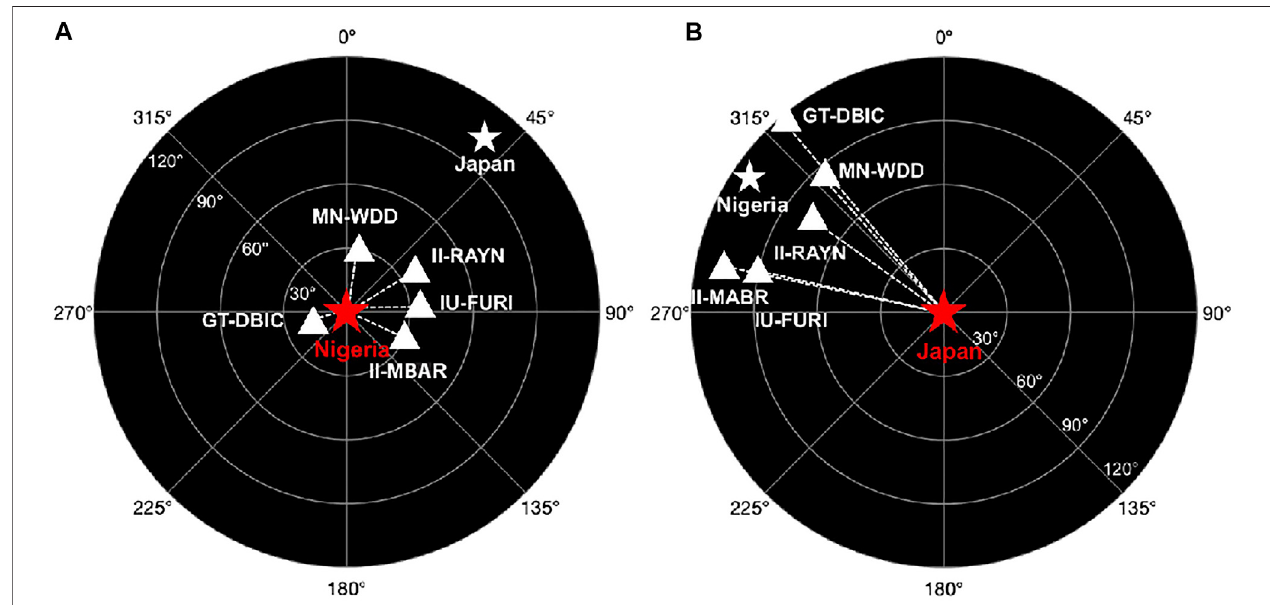
FIGURE 4 | Station locations relative to two hypothetical epicenters (star). (A) For a local or regional event originating from Nigeria or within Western Africa, all stations are expected to be within 30 ° of the event location (red star). (B) For the Hokkaido event, distance is 60 – 120 ° and azimuth 270 – 320 ° (compare Figure 5 ).